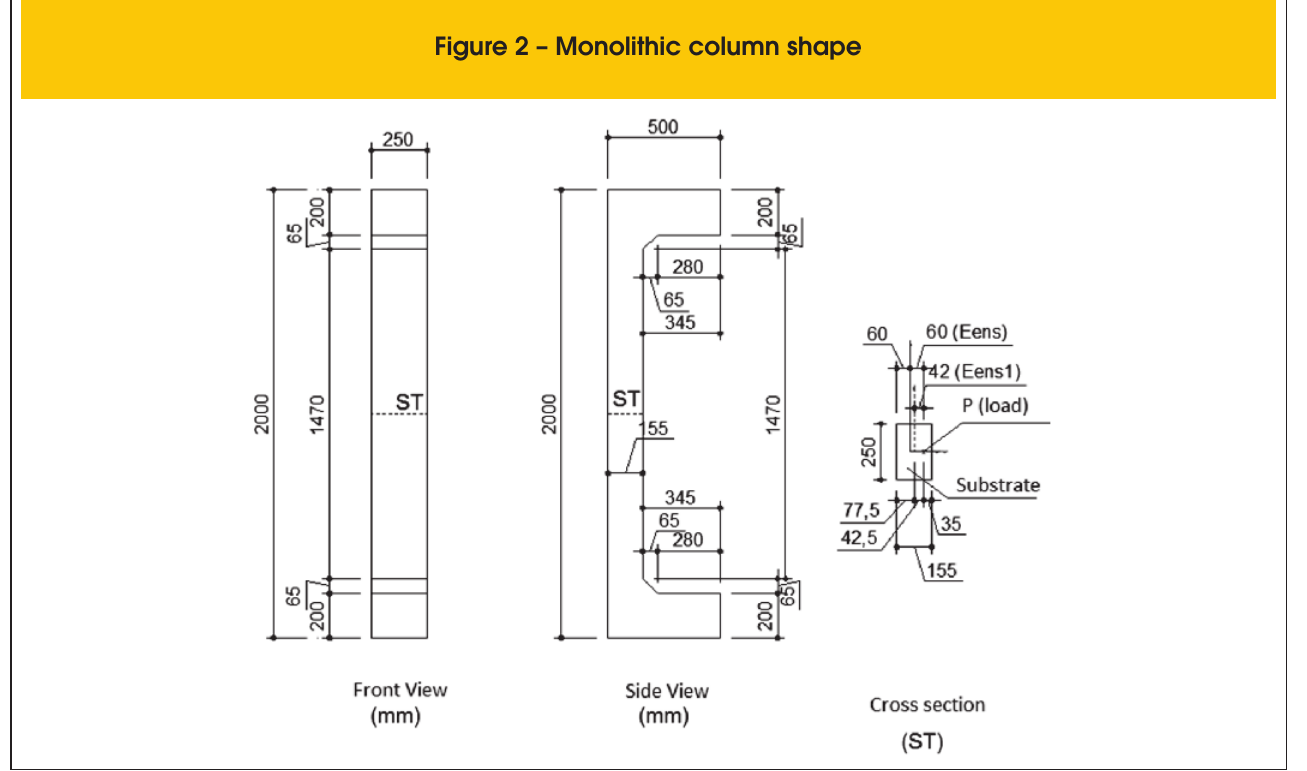
Figure 2 – Monolithic column shape